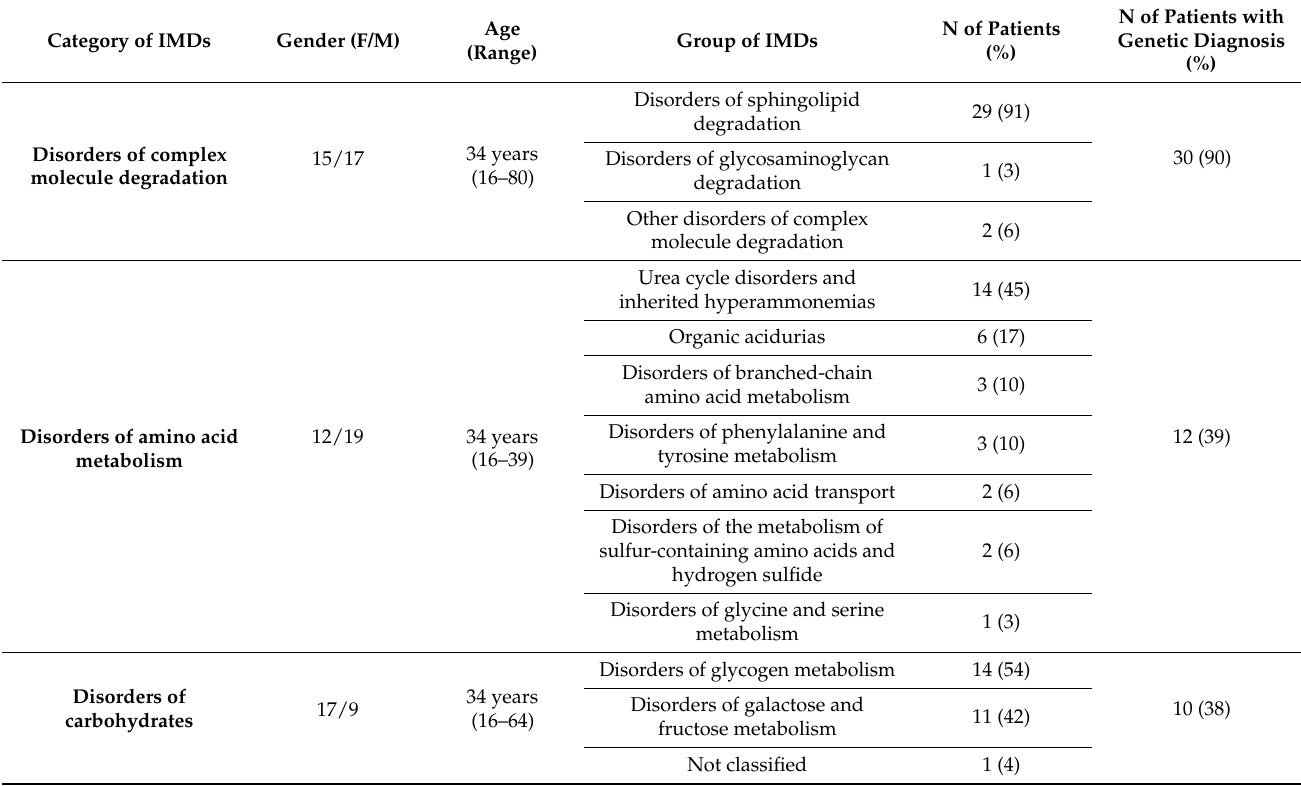
Table 1. Characteristics of the three most represented groups of IMDs in the cohort of